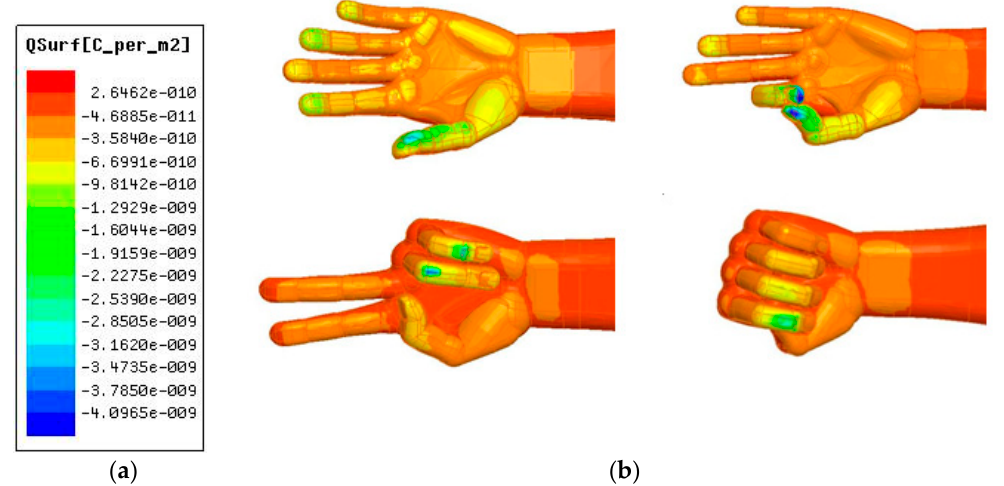
Figure 5. The inductive charge density on the hand: ( a ) Spectral-based charge density meter; ( b ) Charge